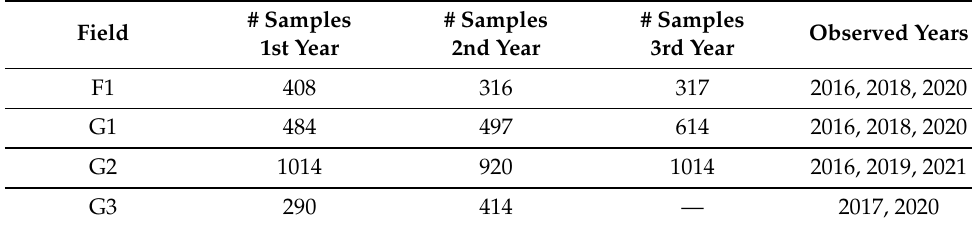
Table 1. Number of samples and years of observation for each field. Field